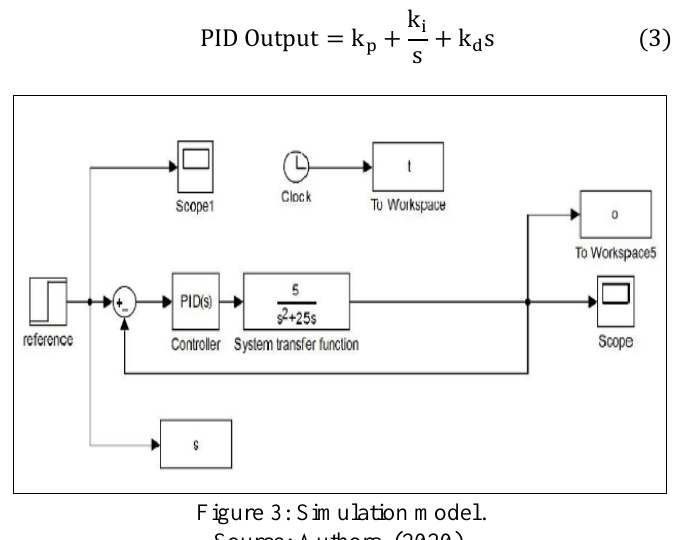
Figure 3: Simulation model.